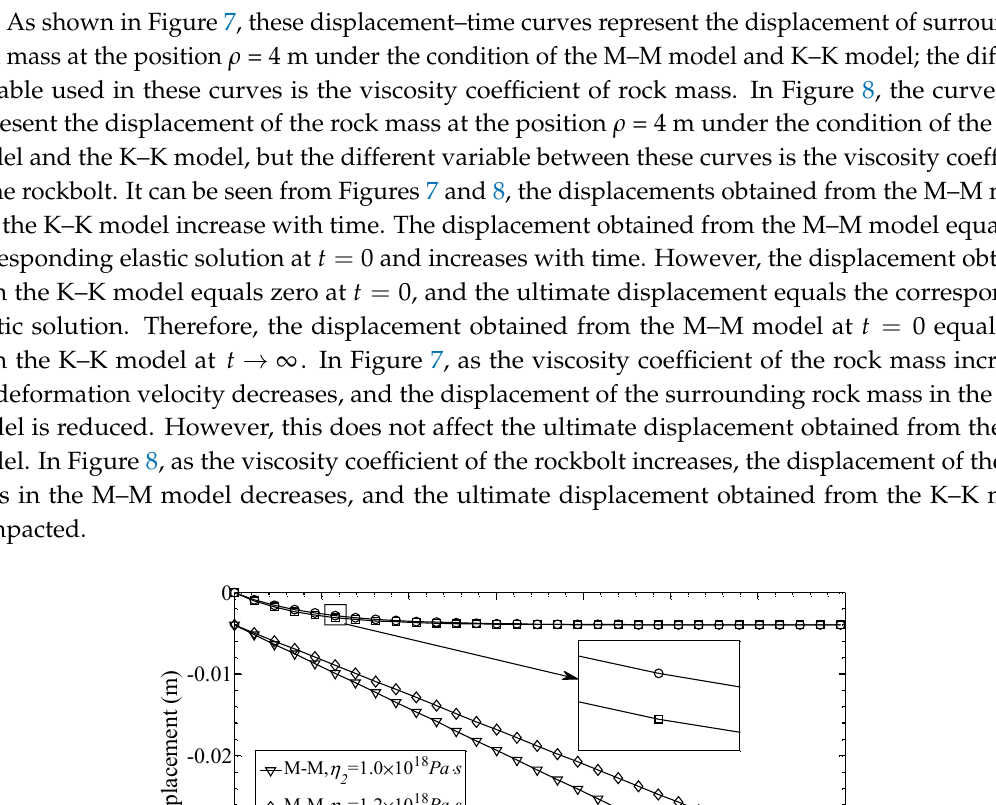
Figure 8. Displacement–time curves obtained from the M–M model and K–K model with different viscosity coefficients of rockbolts. 5. Conclusions In this paper, an interaction rheological model of rockbolt and rock mass is proposed based on the reinforcement mechanism of DMFC rockbolts, and the long-term evolution of stress and displacement of the rock mass and rockbolts are discussed. The main conclusions can be drawn as follows: (1) Based on this study, the time-dependent features of rock mass–rockbolt rheology coupling is considered in the long-term design and maintenance of caverns, and the theoretical model can be used to evaluate the rheological mechanical properties of the interaction between the rock mass and DMFC rockbolts, and then the long-term mechanical behavior of the rockbolt supporting system can be predicted; (2) The evolution of the axial force of a rockbolt is closely related to the viscosity coefficient of rockbolts